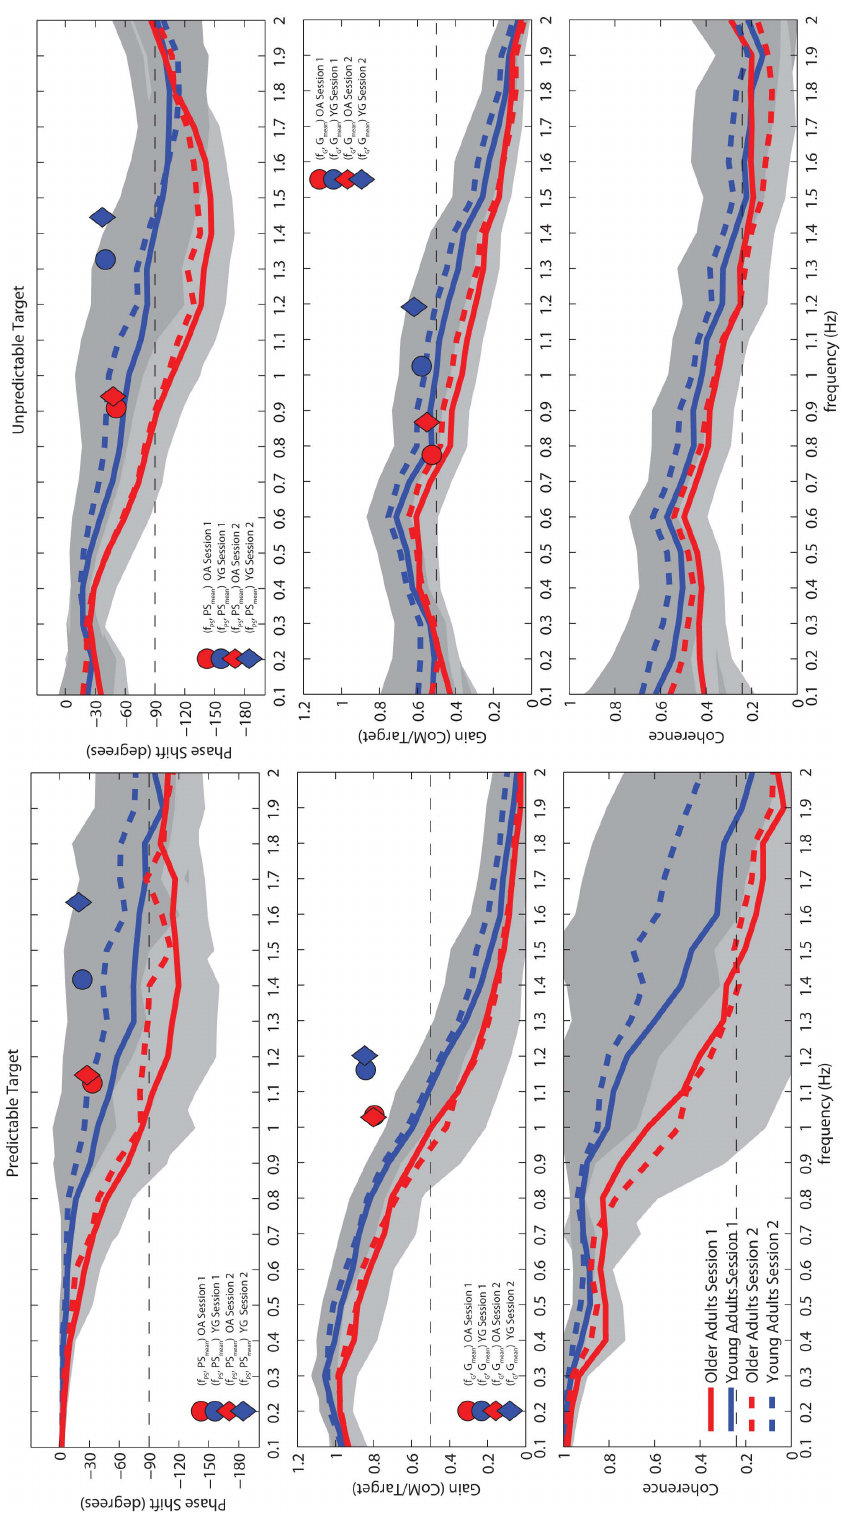
Figure 2. Averaged curves ( 6 sd) for phase shift (top panel), gain (mid panel) and coherence (bottom panel) measures using both, predictable target (left) and unpredictable (right) targets, during first (continuous line) and second (dashed line) sessions and for the younger (in black) and the older adults (in dark grey). Grey shading indicates the 6 sd for all subjects and for all trials. Markers inserted in the plots indicate means for performance descriptors for the first session (circular markers) and second session (diamond markers) for the younger (in black) and the older adults (in dark grey).